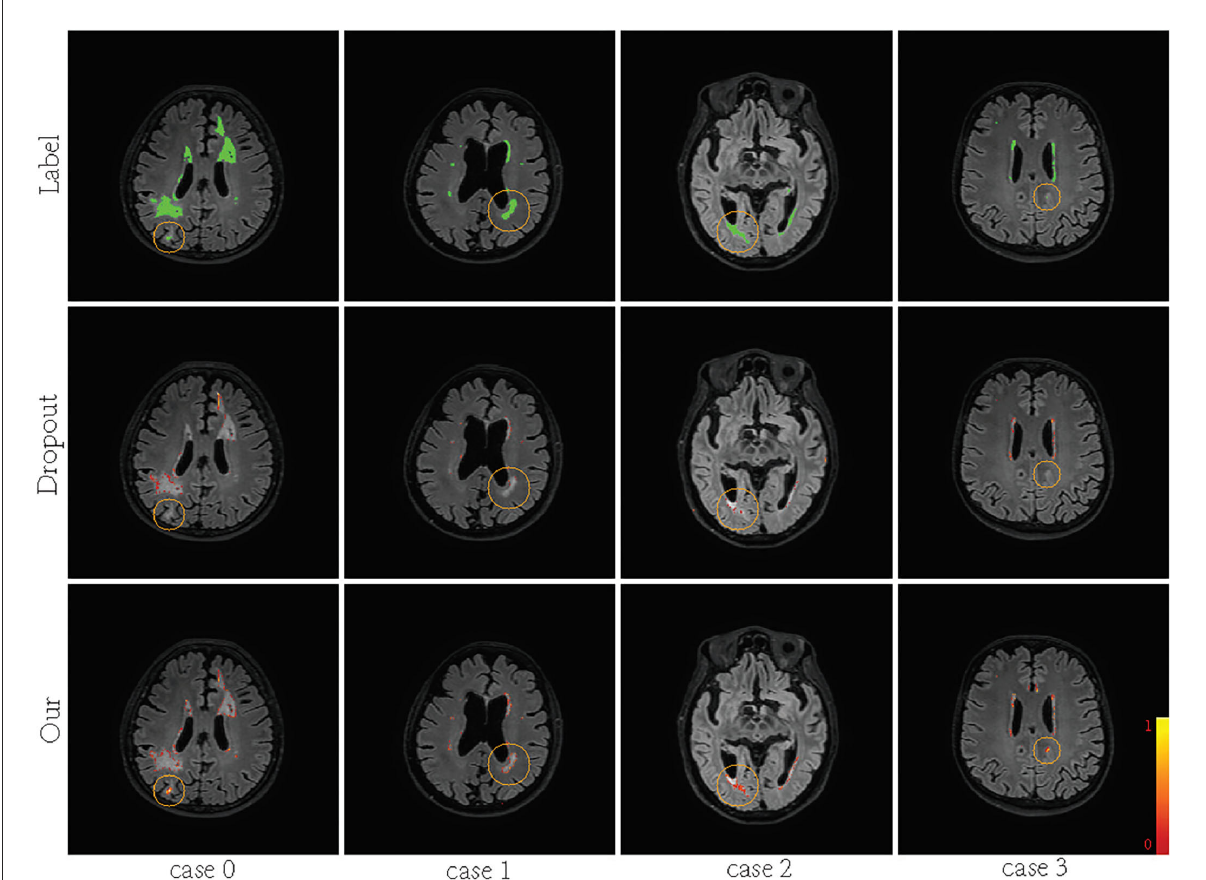
FIGURE9 Visualization of the predictive uncertainty computed by Bayesian U-Net and SA-EN. From top row to bottom row: ground truth, the uncertainty computed by Bayesian U-Net and the uncertainty computed by SA-EN. The green areas indicate ground truth. The magnitude of uncertainty corresponds to the color bar in the lower right corner of the